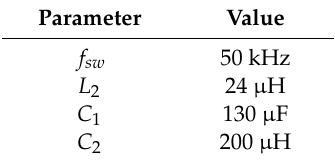
Table 6. Selected values of switching frequency and reactive components for the designed